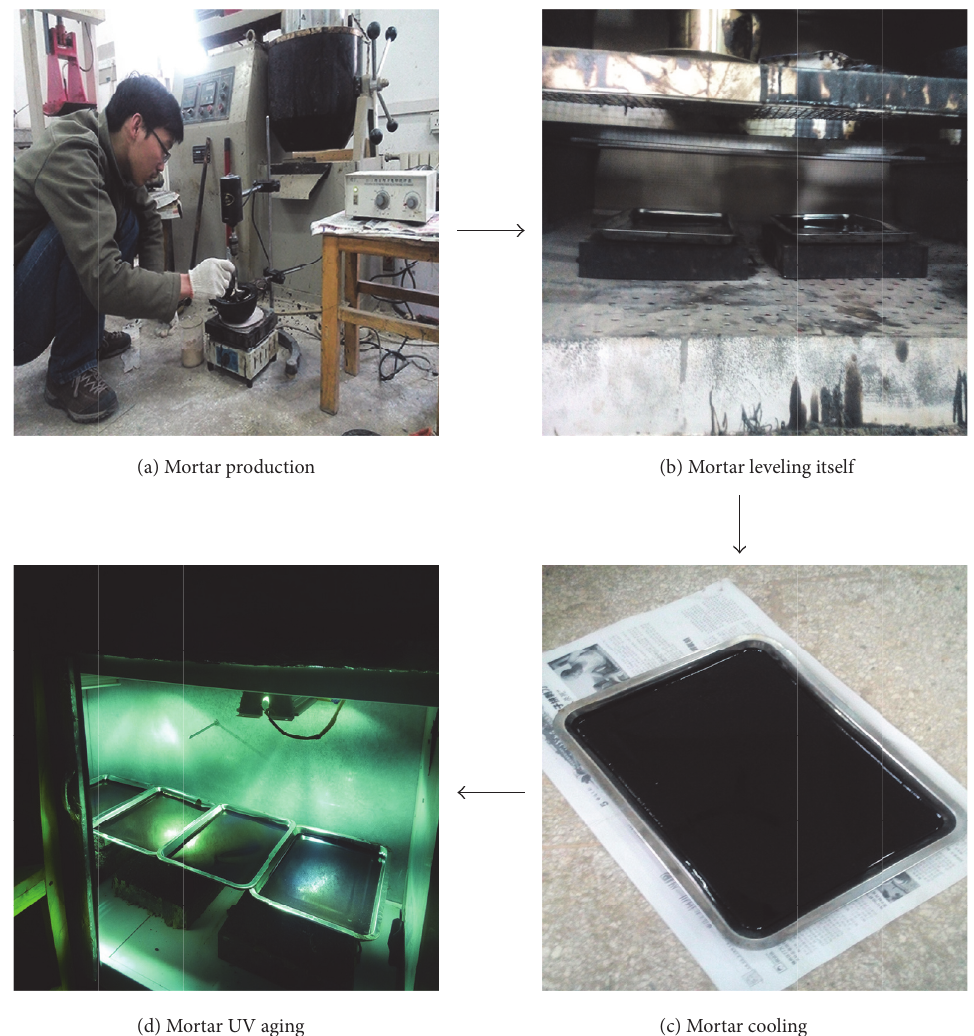
Figure 1: The prepared process of the asphalt